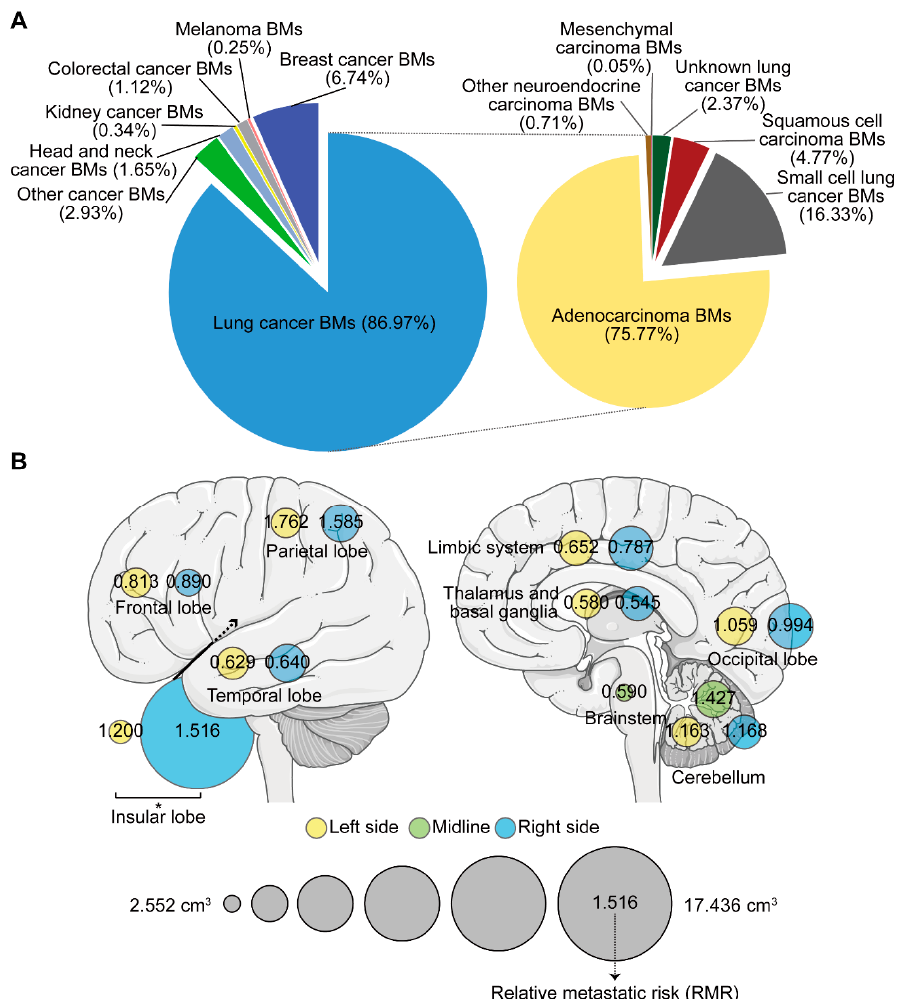
Figure 2. The number, volume, and relative metastatic risk of brain metastases (BMs). ( A ) Composite pie charts indicate the percentage of BMs according to different primary malignancies. The right chart represents the percentage of BMs from different subtypes of lung cancer. ( B ) Schematics showing the average volume of the single lesion of BMs on different sides of distinct brain lobes (circle size), and the corresponding relative metastatic risk (RMR) after normalization to the volume of the brain lobe. BMs refer to brain metastases. *: p < 0.05.